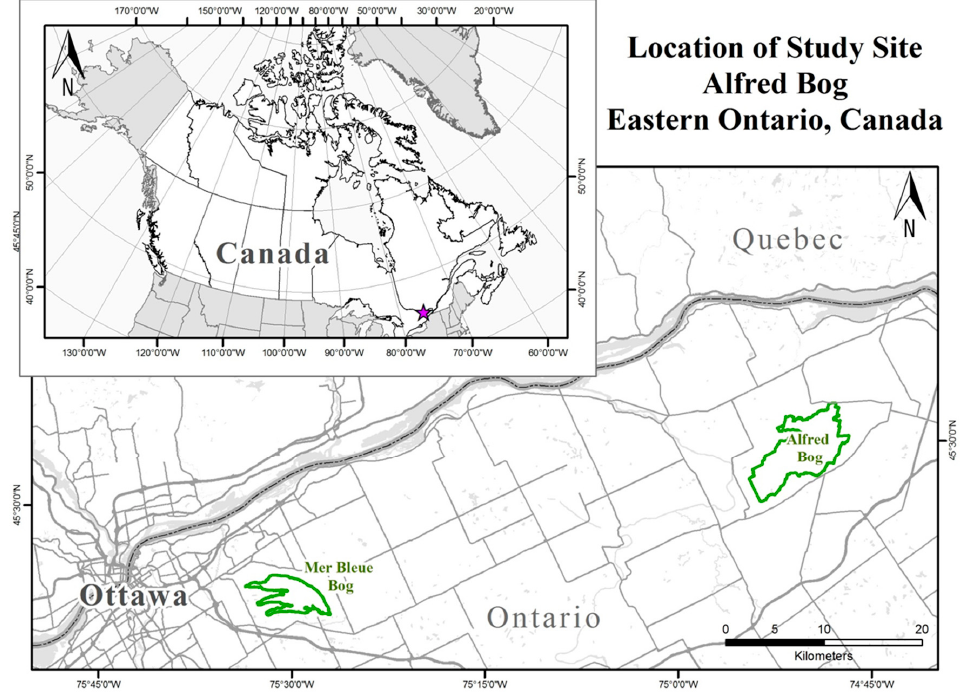
Figure 1. Location map of Alfred Bog [56]. The map in the top left shows Alfred Bog (red star) in relation to the rest of Canada. The lower map is a zoomed in view of Eastern Ontario, and the extent of Alfred Bog is shown as a green polygon to the east. Alfred Bog is located approximately 70 km from the well-known RAMSAR Mer Bleue bog, shown as a green polygon to the west. Mer Bleue and Alfred Bog have very similar land cover classes.